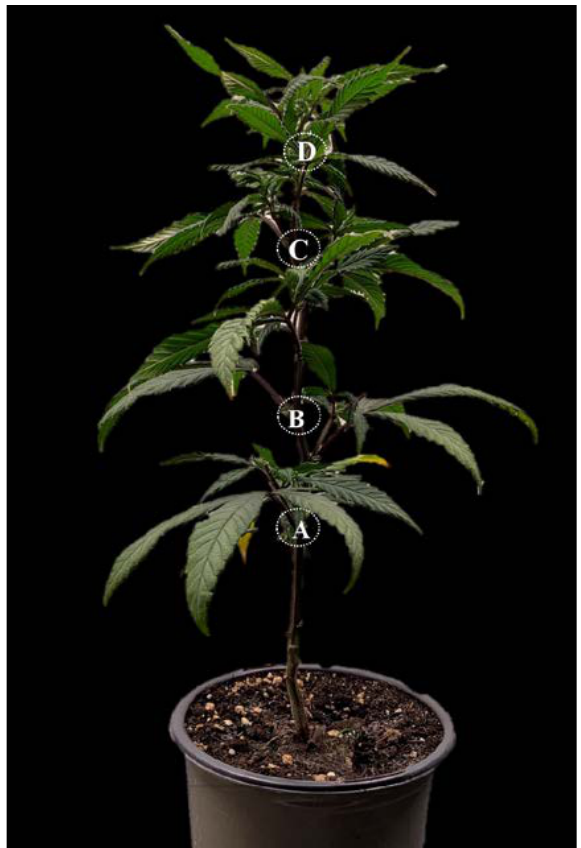
Figure 1. Four different sources of the explants include the basal part (A), near-basal part (B), middle part (C), and apical part (D) of the greenhouse-grown mother plant. part (C), and apical part (D) of the greenhouse-grown mother